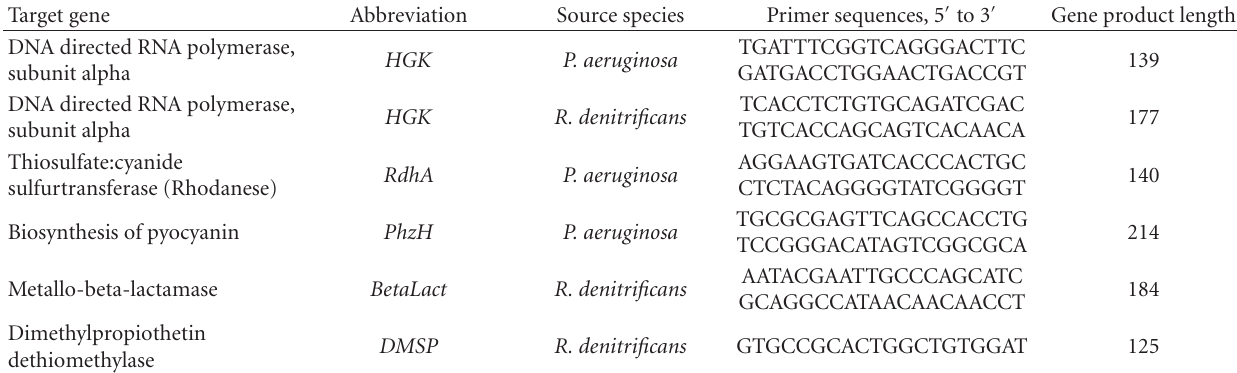
Table 1: Primer sequences used in Quantitative PCR analyses of gene expression of target bacteria in solo and co-cultures.